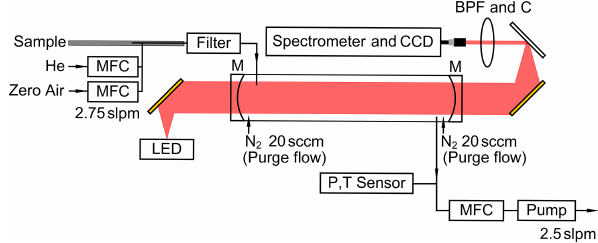
Figure 1. Schematic of the NO 3 BBCEAS system with light path (shaded in red) and gas flows (black arrows). High-reflection mir- rors (M), band-pass filter (BPF), fiber collimator (C), mass flow controllers (MFCs), and sensors of precision pressure transducer (P) and thermocouple (T) are